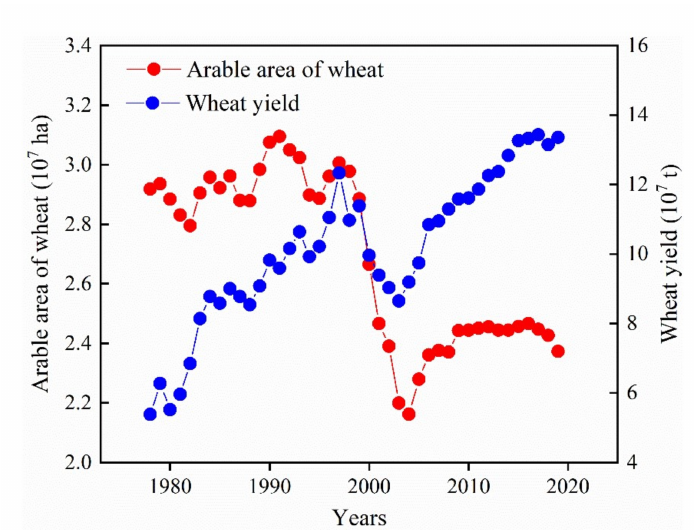
Figure 1. The arable area of wheat and wheat yield from 1978 to 2019 in China. Data were provided by National Bureau of Statistics of China (http://www.stats.gov.cn/english/, accessed on 30 June